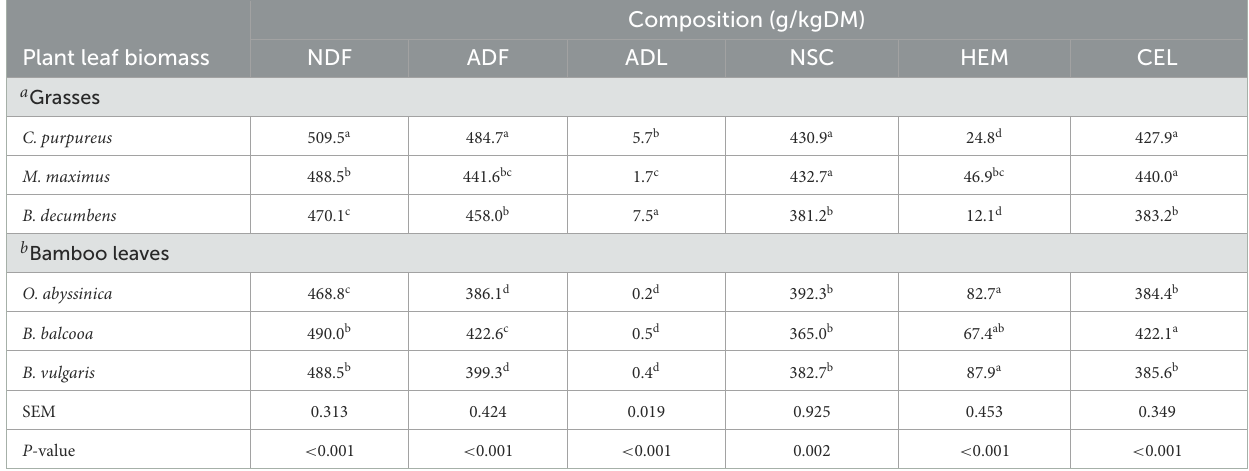
TABLE 2 Analytical detergent fiber fractions of bamboo and grass leaf samples.